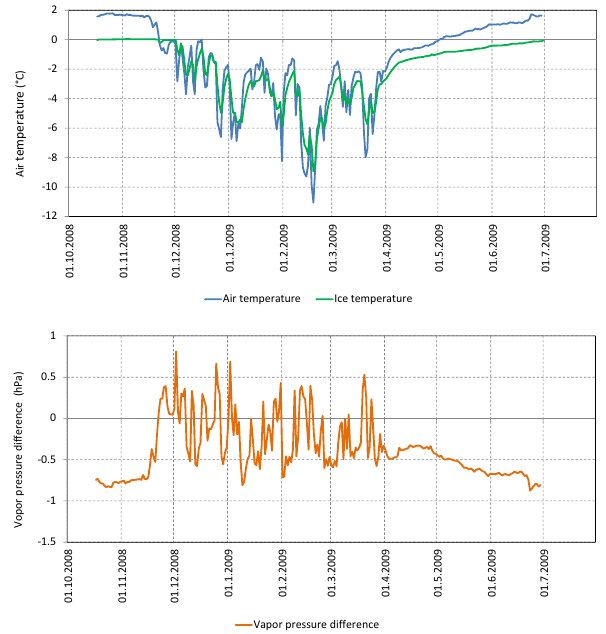
Fig. 10. Daily means of air temperature, ice temperature (top panel) and computed vapour pressure difference (ice surface minus air) for AWS-location Posselthalle in the cave Eisriesenwelt for the period 1 April 2009 to 30 September 2009. Vapour pressure was computed from air temperatures under the assumption of saturation using the empirical